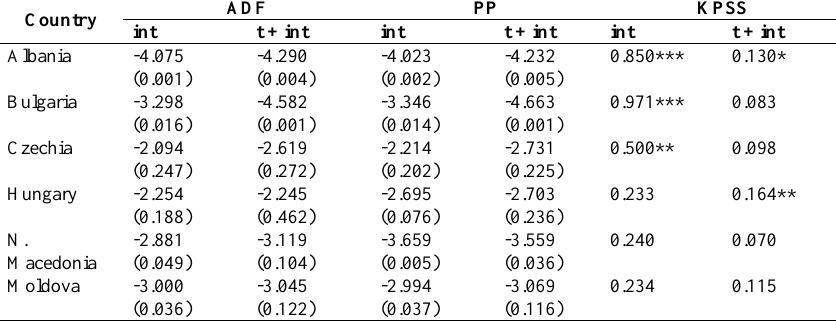
Table 2. Standard univariate unit root and stationarity tests for real interest rate